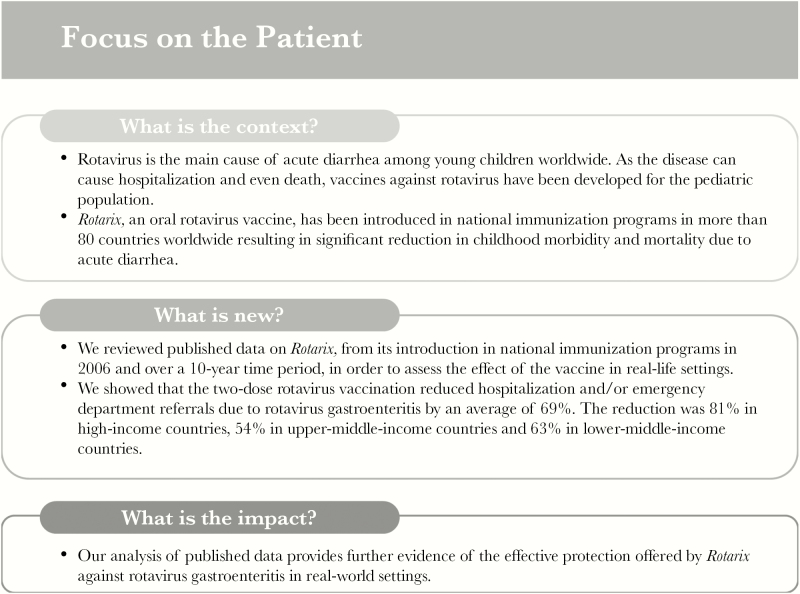
Focus on the patient section.